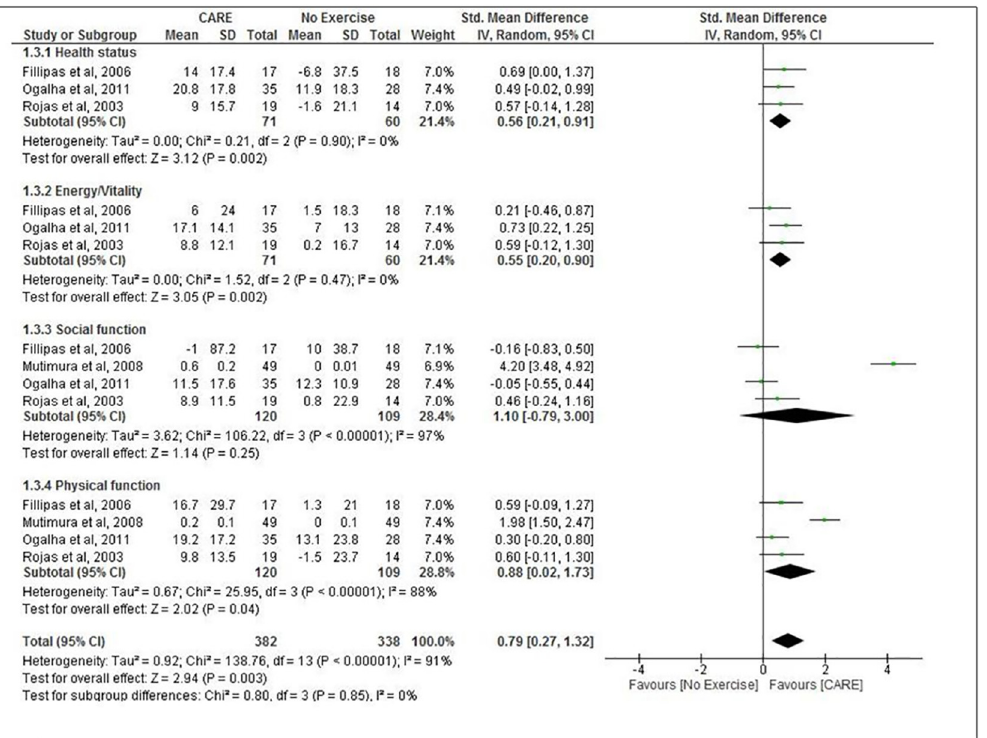
PLOS ONE | DOI:10.1371/journal.pone.0138066 September 17,